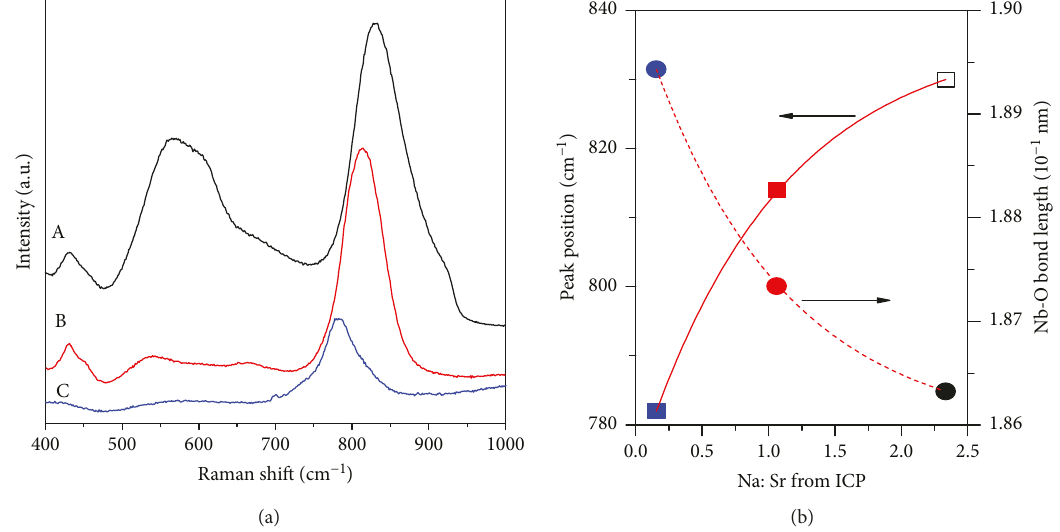
Figure 2: (a) Raman scattering spectra of samples prepared from di ff erent ratios and (b) plot of Raman peak position vs. Na:Sr ratio.